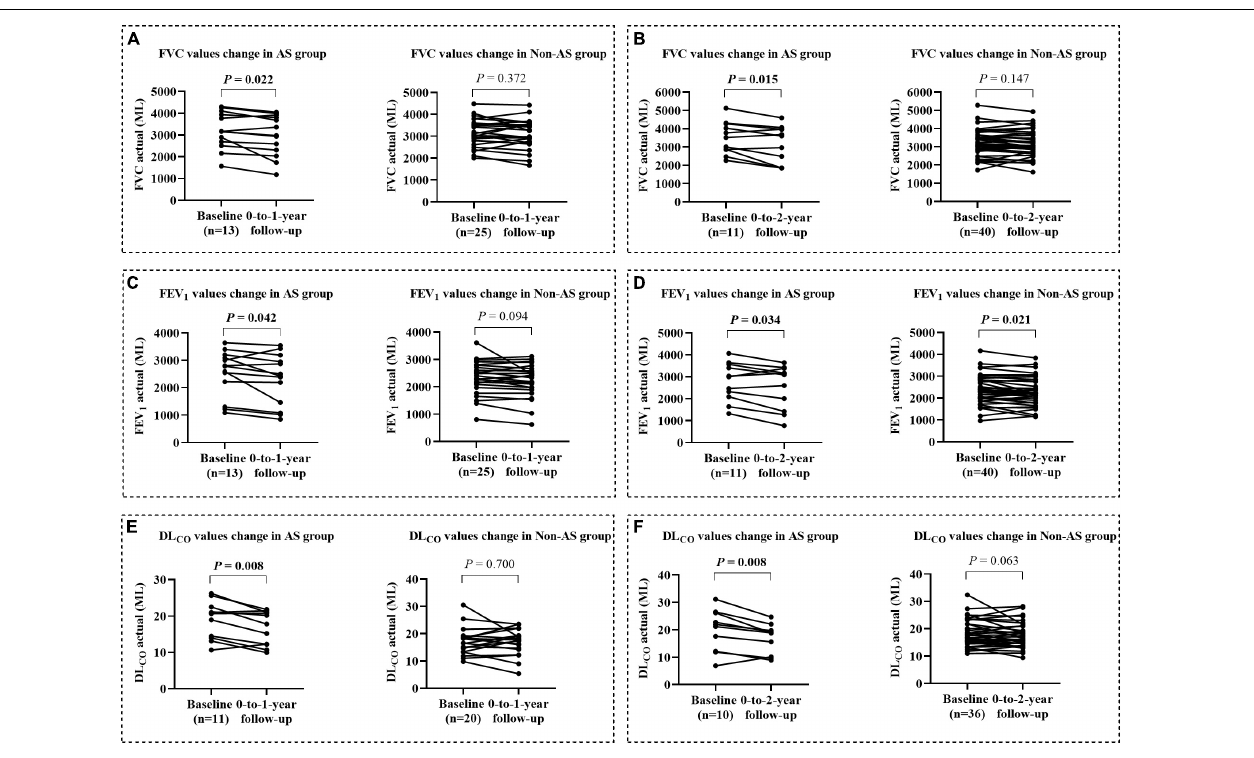
FIGURE 3 | The changes of lung function from baseline to the values at 0-to-1-year and 0-to-2-year followed up in AS and non-AS groups. Changes of FVC, FEV 1 , and DL CO (mL) from baseline to the values after 1 (A,C,E) and 2 years (B,D,F) follow-up. FVC, forced vital capacity; FEV 1 , forced expiratory volume in 1 s; DL CO , diffusing capacity of the lung for carbon